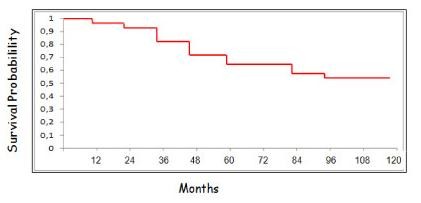
Overall Survival.